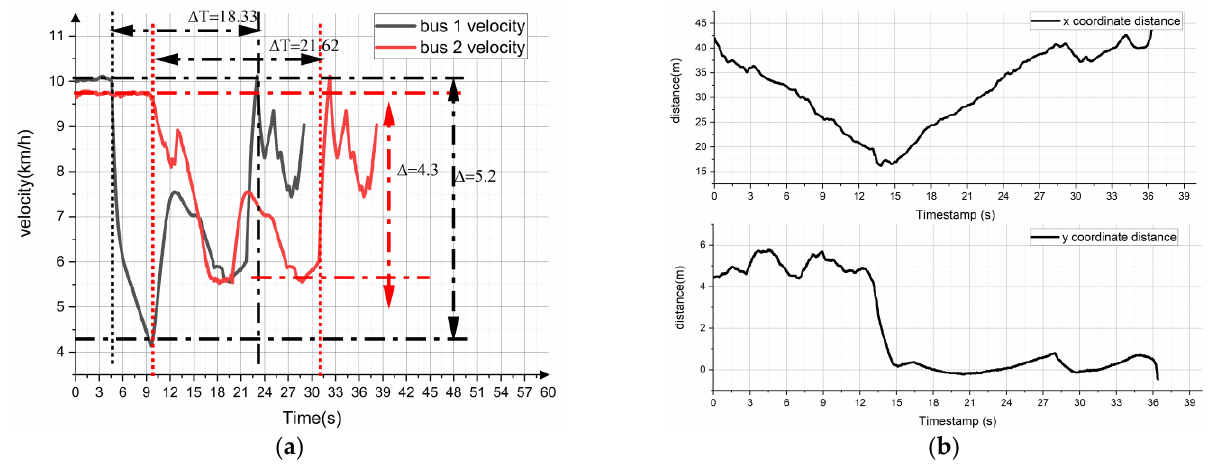
Figure 22. Speed and relative distance of real vehicle test 2: ( a ) queue vehicle speed with flexible following factor and flexible fading factor; ( b ) queue vehicle transverse–longitudinal trajectory with flexible following factor and flexible decay factor.